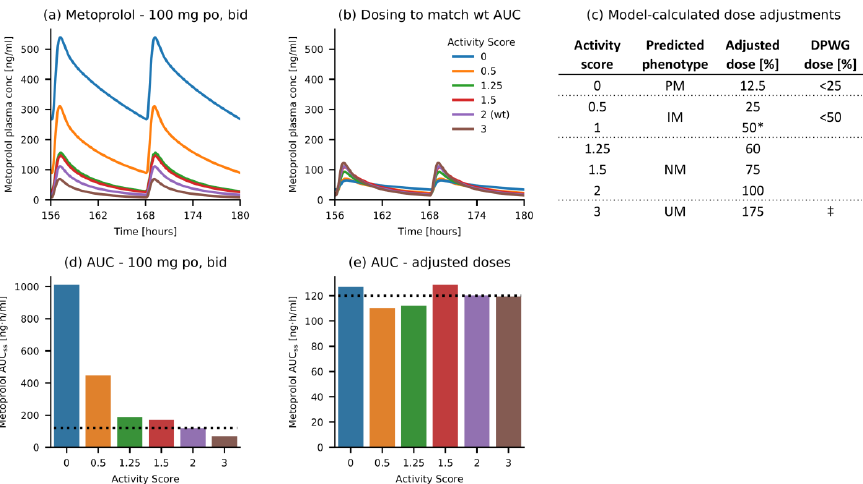
Figure 6. Model-based CYP2D6 DGI dose recommendations. ( a ) Simulations of metoprolol exposure in Figure 6 individuals with different CYP2D6 activity scores, all administered with 100 mg metoprolol twice daily. ( b )SimulationsofmetoprololexposureinindividualswithdifferentCYP2D6activityscores, administered with the model-based dose recommendations. Doses were adjusted to match the AUC 168–180 h of 100 mg metoprolol twice daily in AS = 2 (wt) individuals. ( c ) Model-based dose adjustments, compared to the DPWG guideline recommendations for metoprolol [28]. ( d ) Metoprolol AUC 168–180 h values for administration of 100 mg twice daily to individuals with di ff erent CYP2D6 activity scores. ( e ) Metoprolol AUC ss values for administration of the model-based dose recommendations to individuals with di ff erent CYP2D6 activity scores. The dotted horizontal line marks the wt AUC ss . *: value interpolated due to a lack of clinical studies with AS = 1, ‡ : dose titration or change of medication recommended, AS: activity score, AUC ss : area under the plasma concentration-time curve during steady state (168–180 h), bid: twice daily, DPWG: Dutch Pharmacogenetics Working Group, IM: intermediate metabolizer, NM: normal metabolizer, PM: poor metabolizer, po: oral, UM: ultrarapid metabolizer, wt: wild